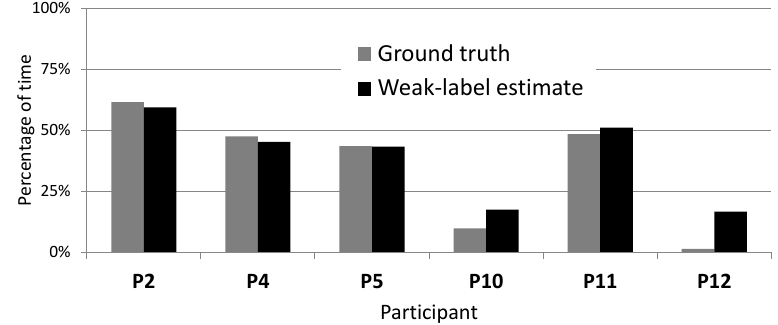
Figure 12. Comparing true percentage of tremor to percentage estimated from weak labels on LAB data.